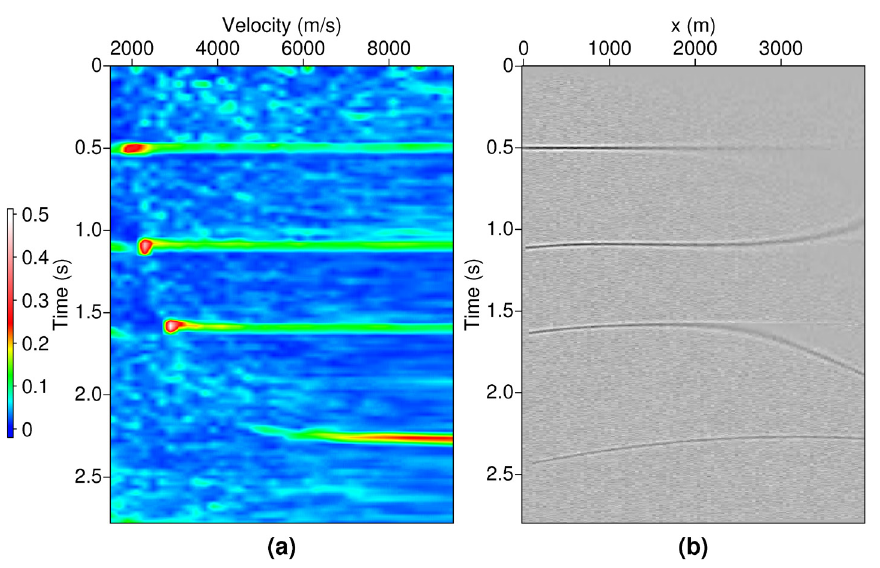
Figure 3. a) CMP family semblance panel shown in Figure 2b. b) The same CMP family after the conventional velocity analysis corrected for the NMO